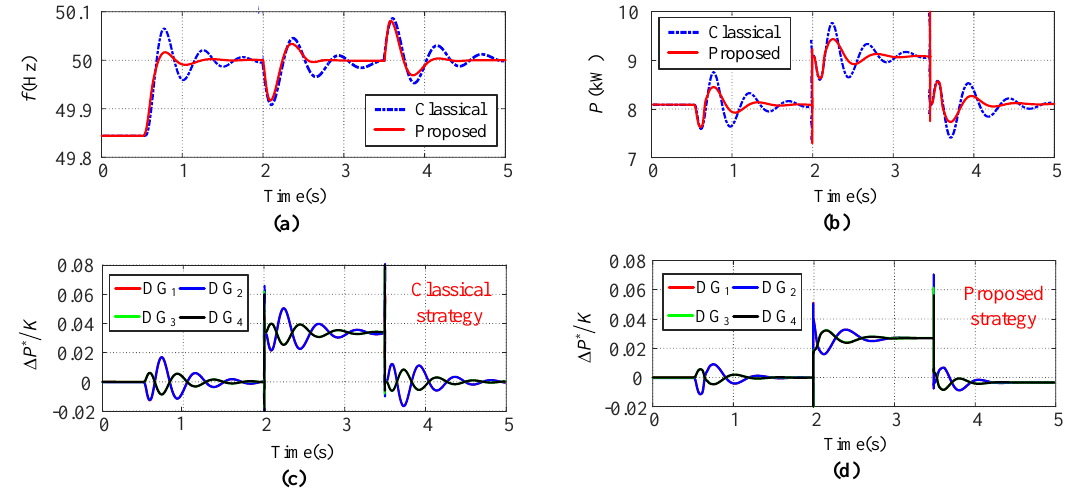
Figure 8. Comparison of the delay robustness of the proposed strategy and that of the classical feedback linearization strategy when τ = 0.5 s: ( a ) frequency of DG1; ( b ) output active power of